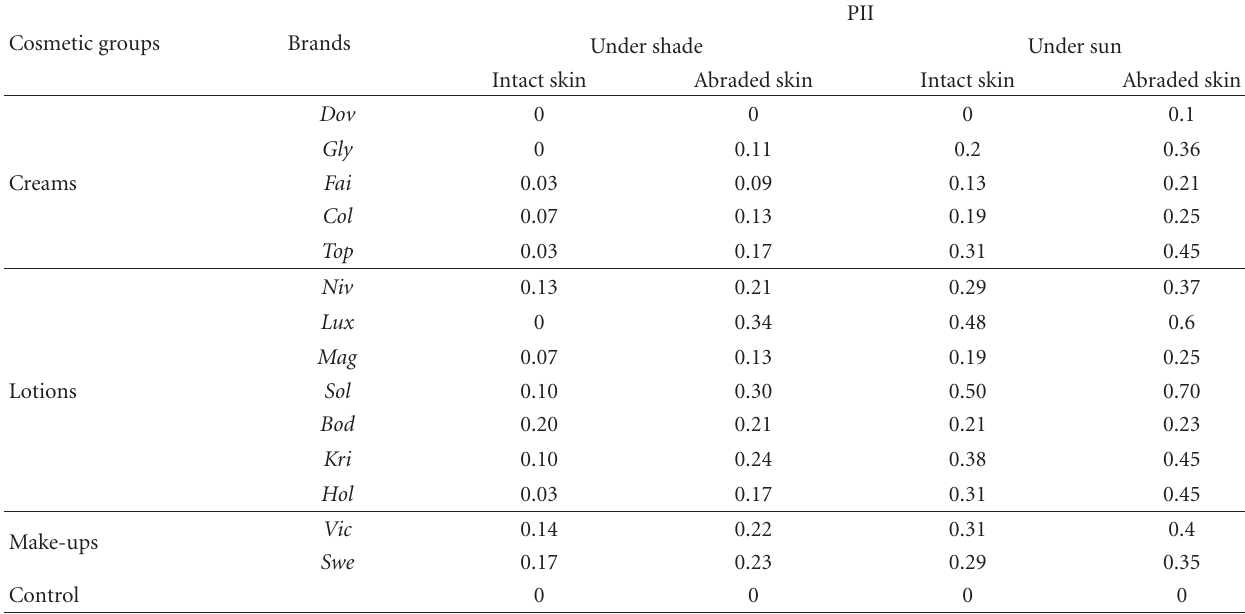
Table 4: Primary irritation index (PII) of creams, lotions, and make-ups applied on rabbit skin for five consecutive days, under shade and under sun, Jimma town, 2011. The results were calculated from combined erythema and edema ratings for three rabbits at five observation